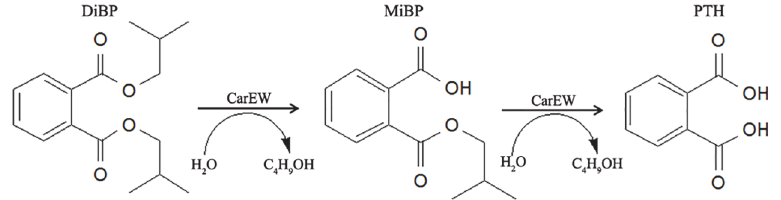
Fig 7. Proposed pathway for incomplete diisobutyl phthalate degradation by